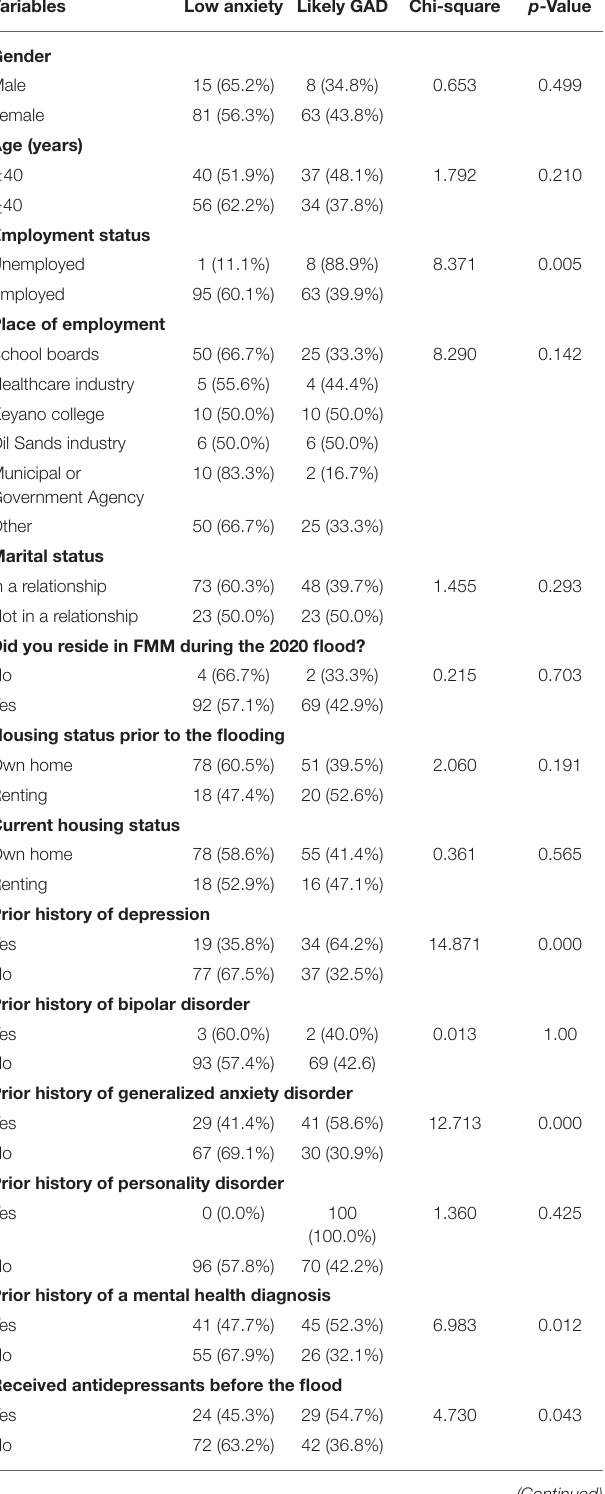
TABLE 4 | Chi-squared test of association between demographic, clinical, flood-related variables and likely GAD.